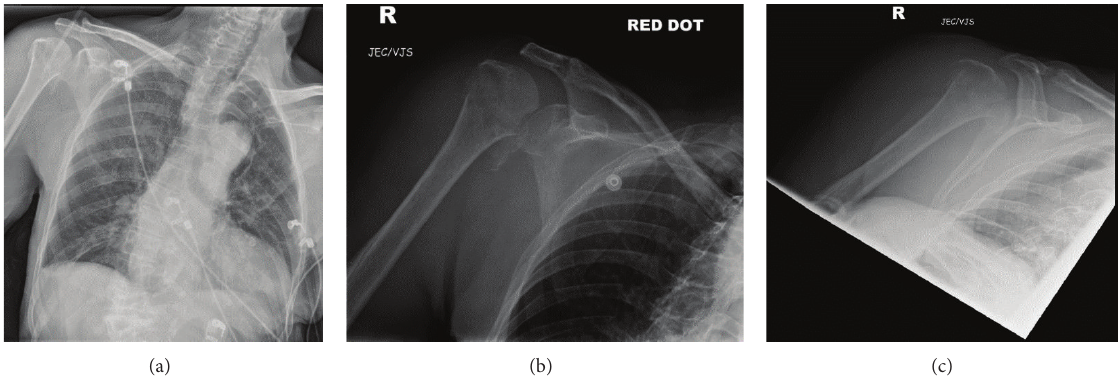
Figure 1: AP chest (a) and right shoulder AP (b) and Y-view (c) radiographs in A&E.